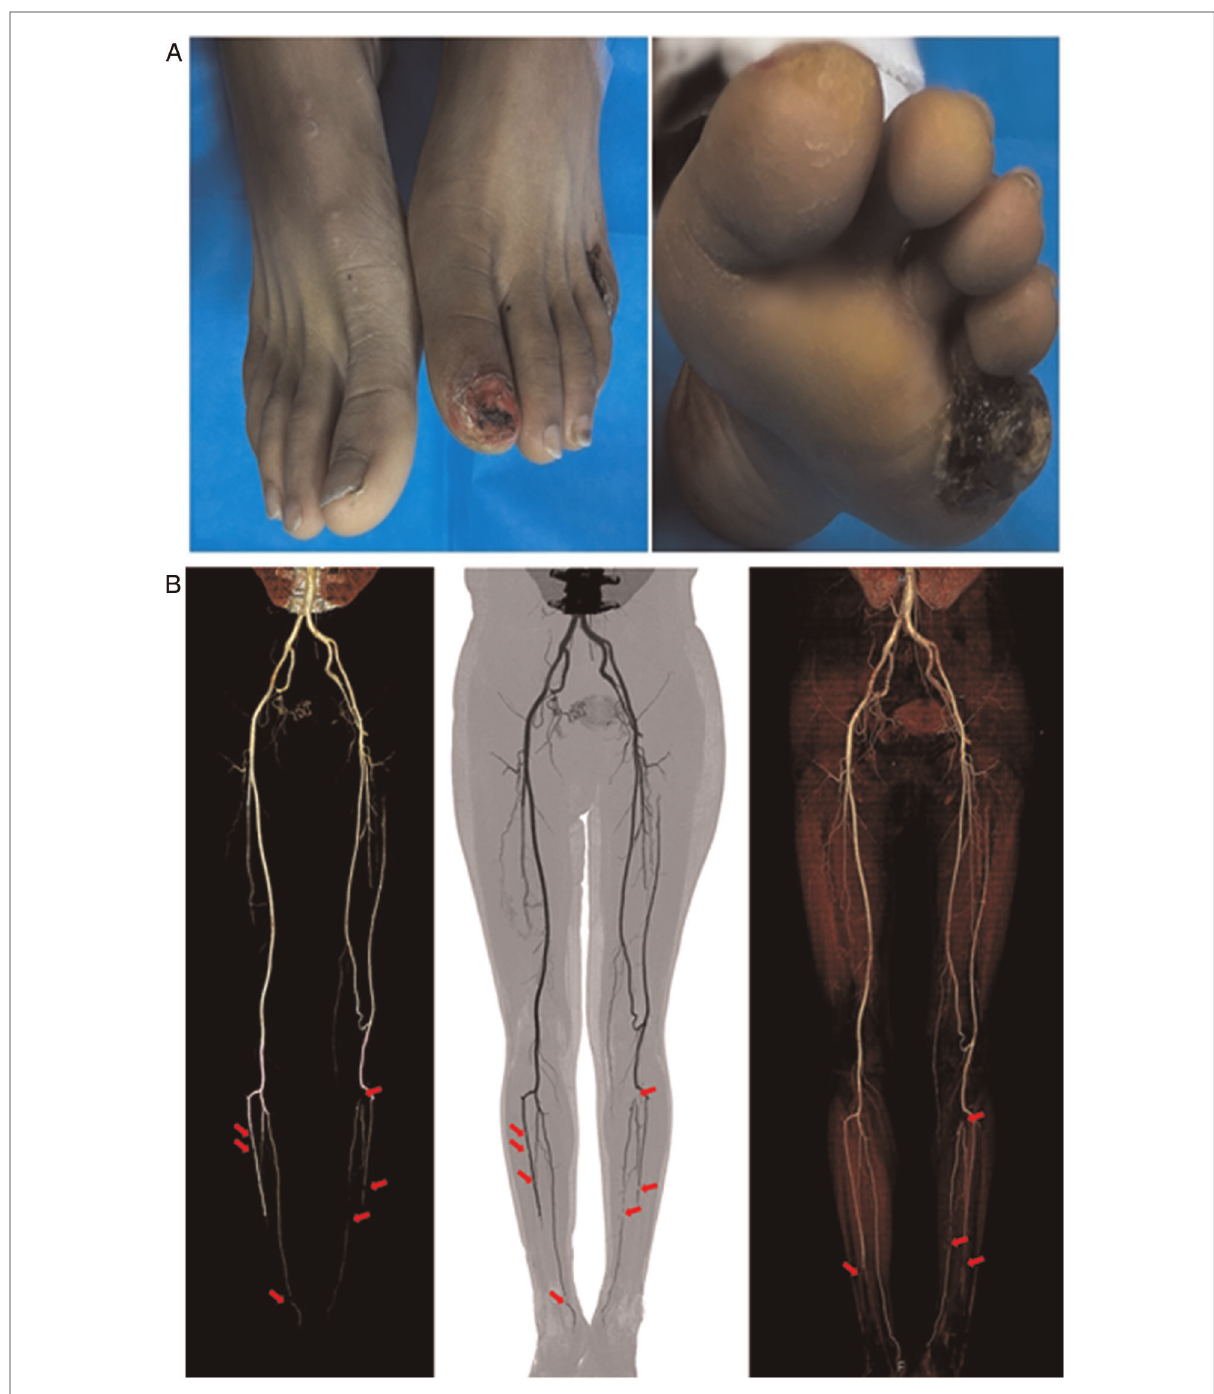
a vacuum negative pressure gauge (0.02 – 0.04 MPa) was connected ( Figure 2 ). Tissue and skin were bandaged with sterile dressings. There was no need to use tourniquets and electrocautery during the